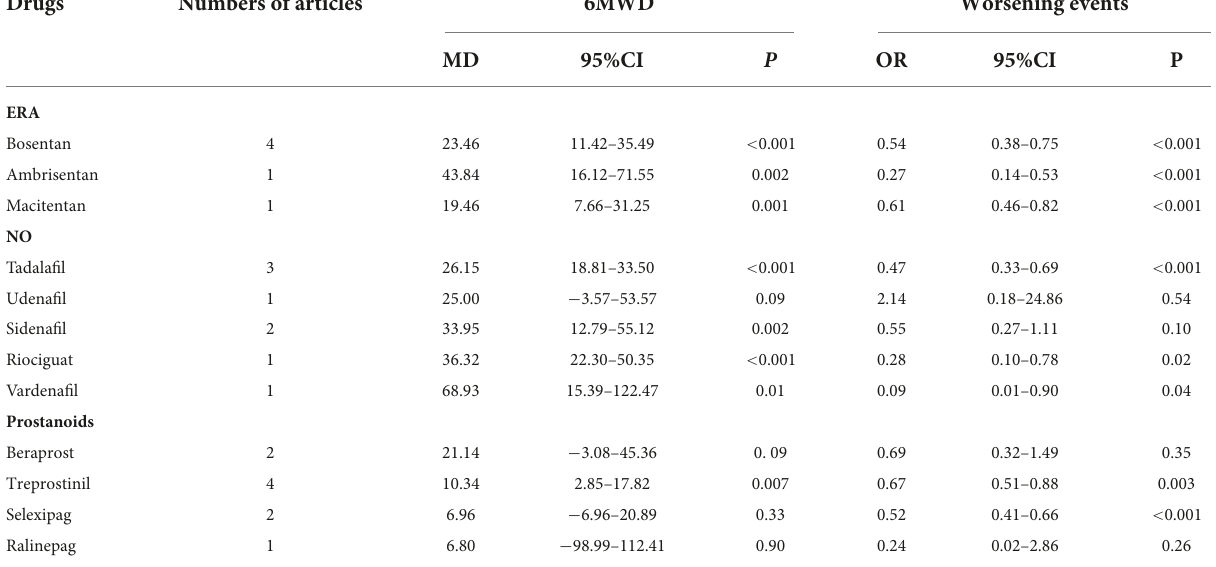
TABLE 6 Subgroup meta-analysis based on drug classes and